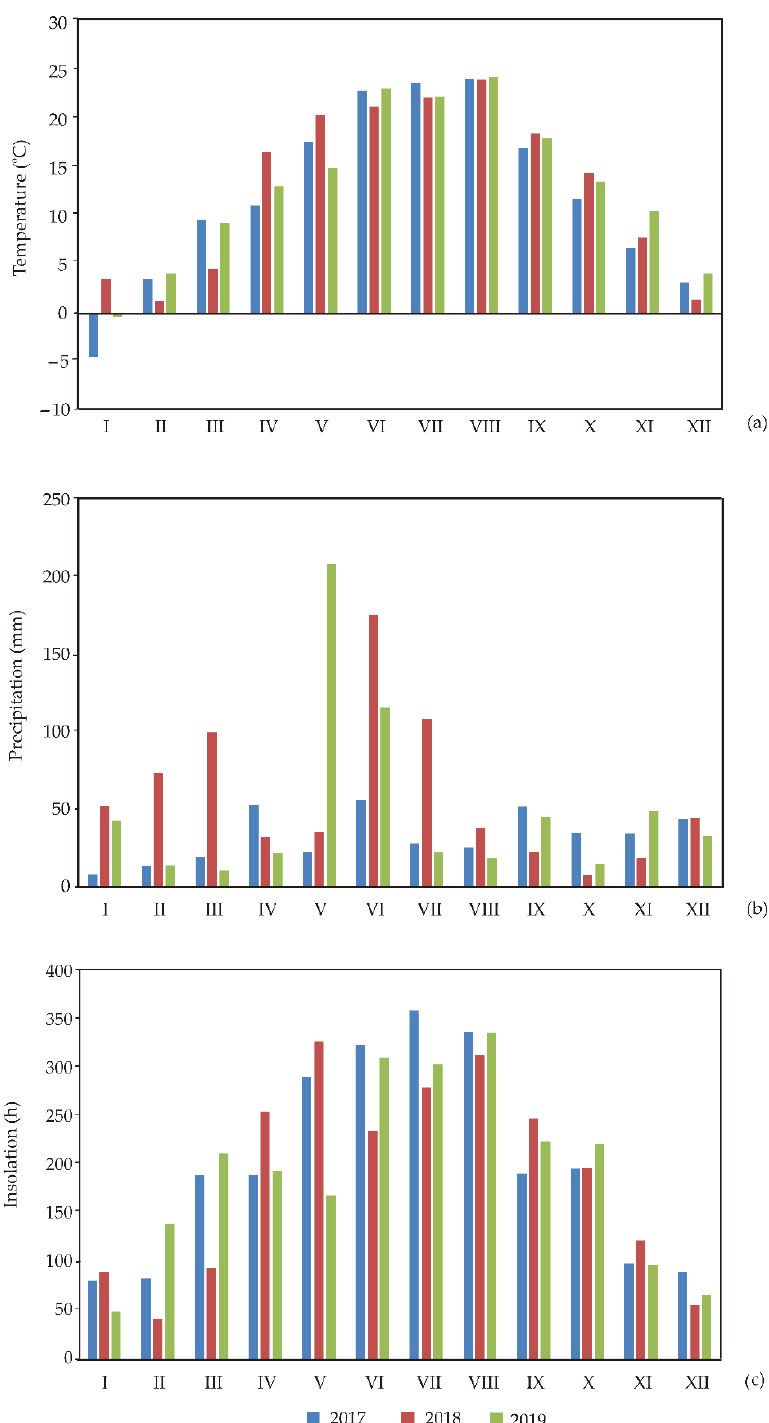
Figure 2. The average daily temperatures ( a ), the sum of precipitation ( b ), and the sum of insolation ( c ) during observed period.